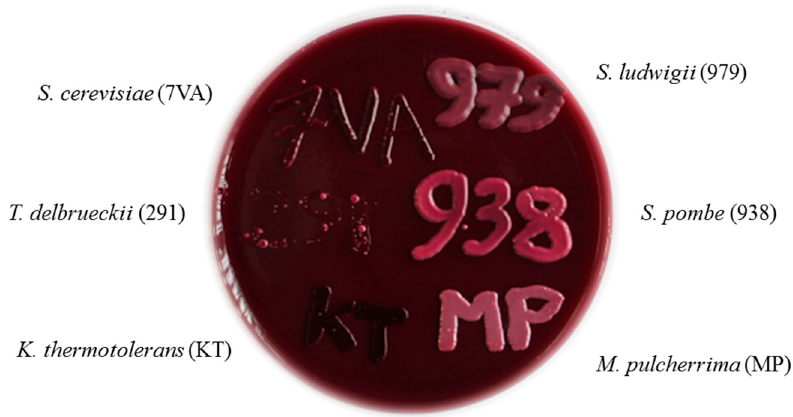
Figure 4. Adsorption of grape anthocyanins in yeast cell walls ( Saccharomyces and non- Saccharomyces ) during growth in a specific plating media containing pigments.